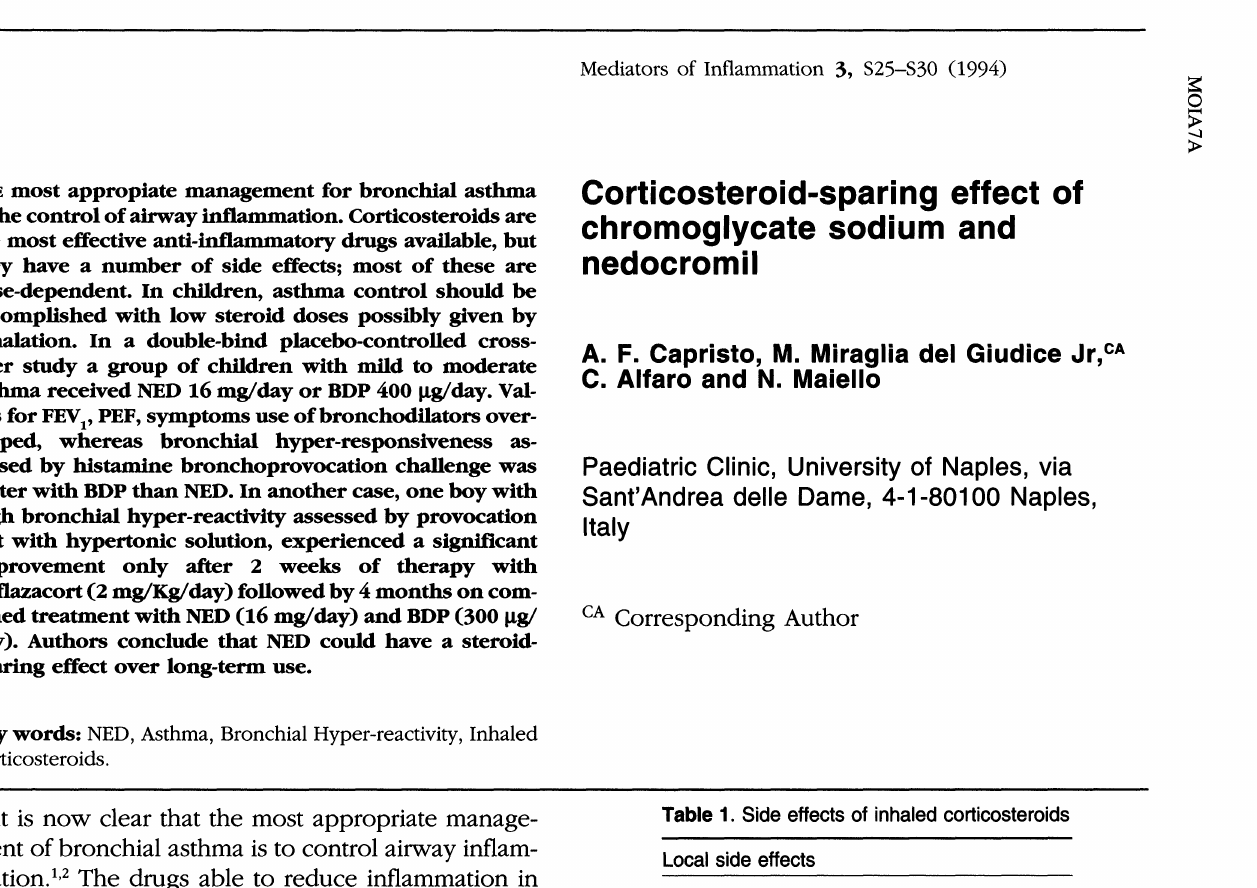
Table 1. Side effects of inhaled corticosteroids